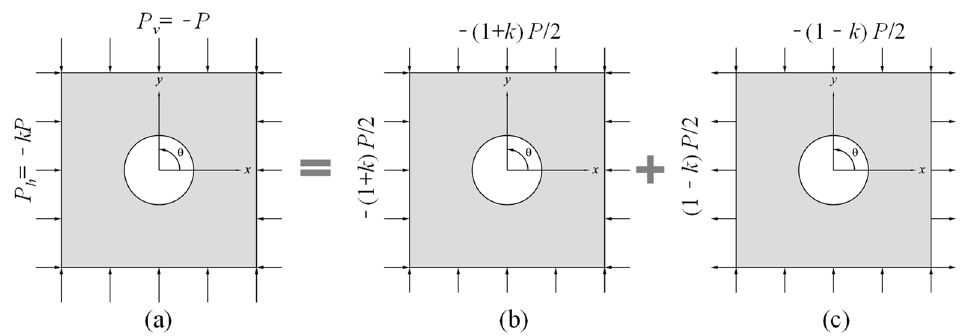
Figure 4. Illustration for ground soil with circular tunnel excavation. ( a ) Superposition; ( b ) Hydro- static condition; ( c ) Deviatoric condition.